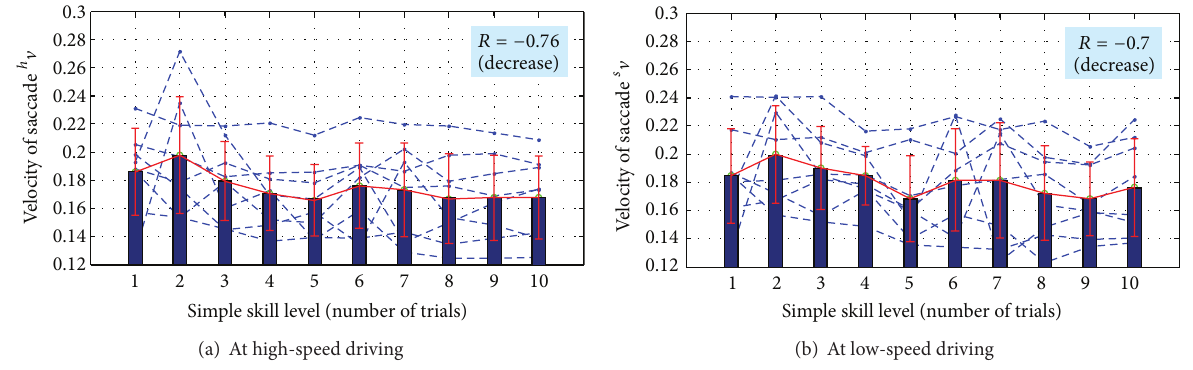
Figure 7: Transition of velocity of saccade in a cooperative-carrying task.